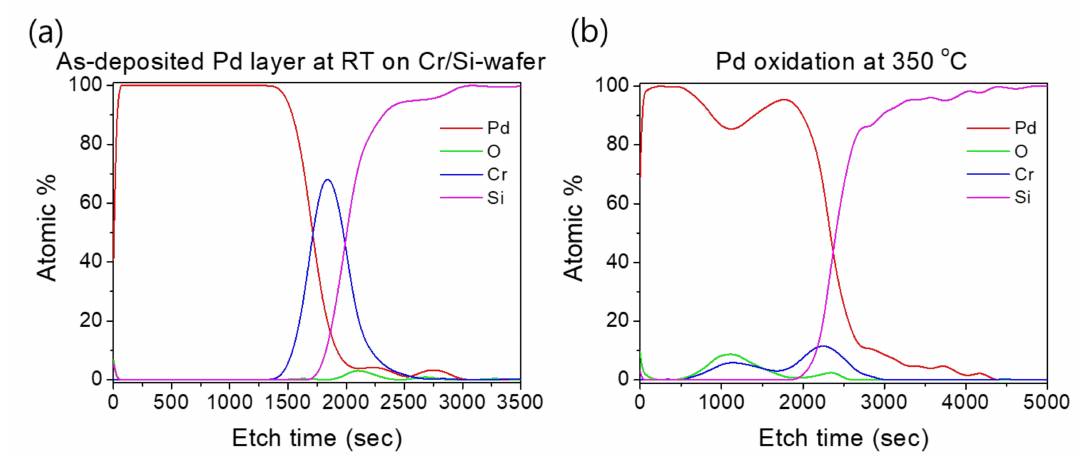
Figure 10. AES profiles showing the effect of temperature on Pd and Cr distribution during the thermal oxidation process. ( a ) As-deposited Pd film on a Cr-coated Si-wafer; ( b ) Pd film oxidation at 350 ◦ C for 30